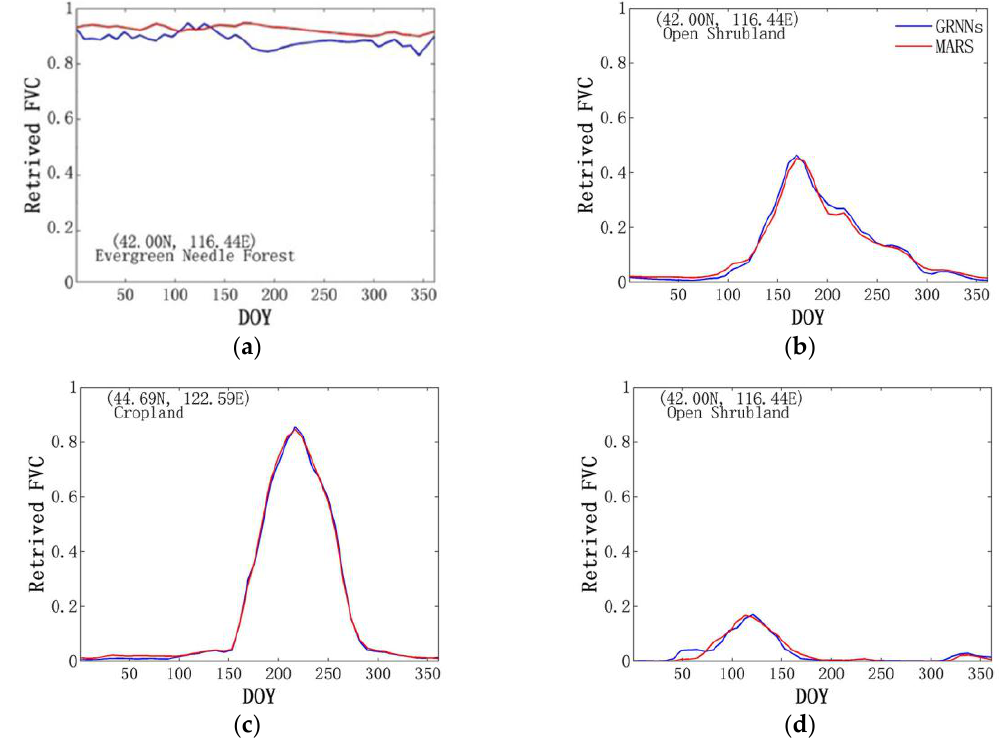
Figure 5. Temporal profiles of the MARS derived FVC and the GRNNs derived FVC over sampling sites for year 2003: ( a ) Evergreen needle forest; ( b ) Grassland; ( c ) Cropland; and ( d ) Open shrubland.